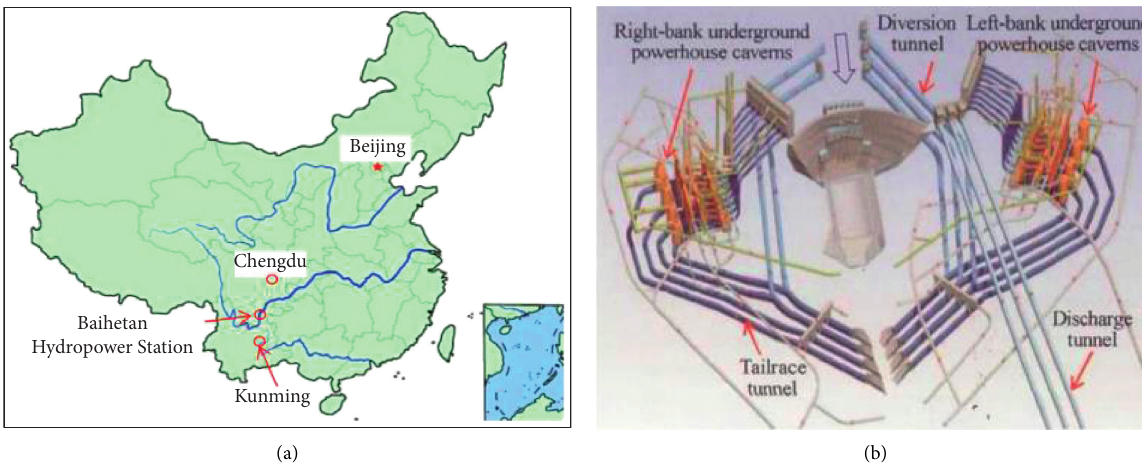
Figure 3: Project overview [15]. (a) The drilling and scoring position. (b) Layout of underground powerhouse caverns